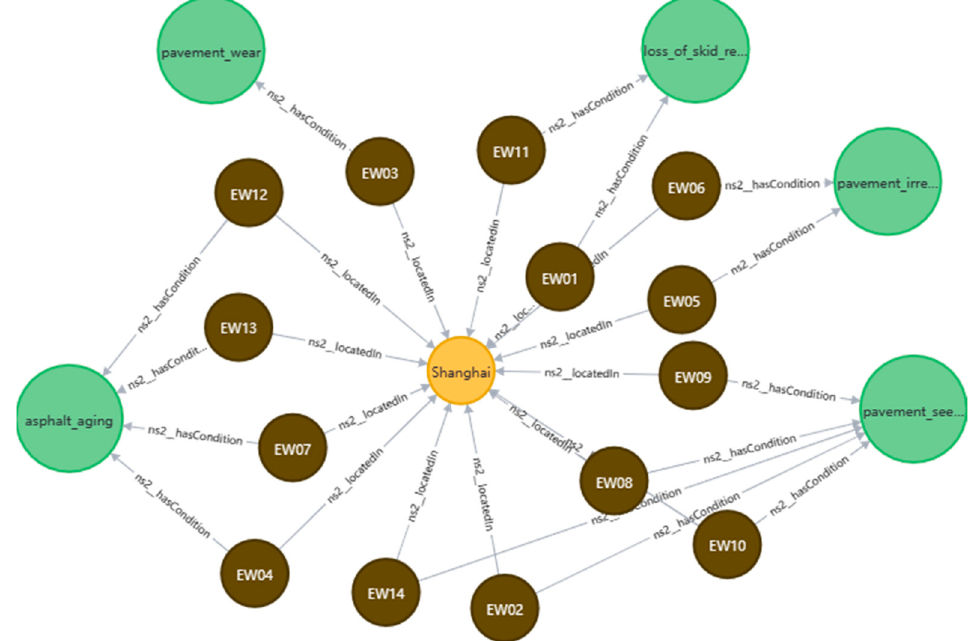
Figure 6. Urban road renewal knowledge graph.